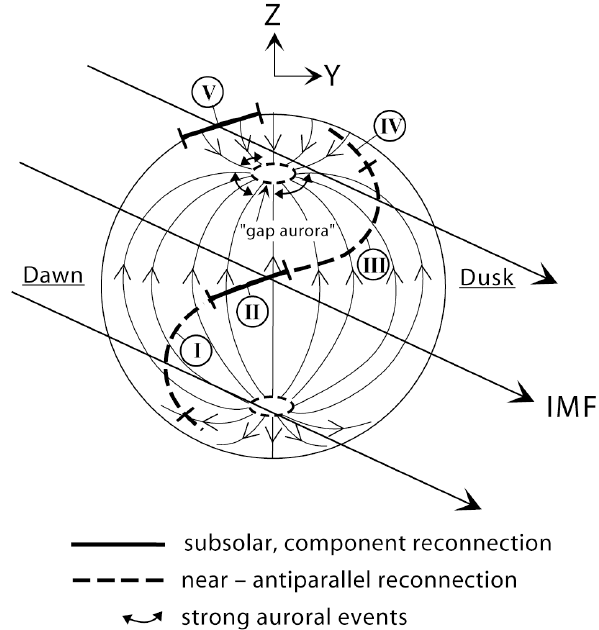
Figure 25 Fig. 25. Reconnection topology for a southeast directed IMF. The Earth’s field (just inside the magnetopause) is indicated. The per- spective is from the Sun towards the Earth. IMF field lines merg- ing with the Earth’s field in different sectors are superimposed. A tilted reconnection line, representing component reconnection at the subsolar, stagnant magnetopause (solid line; segment II) con- nects sectors favourable to antiparallel merging (dashed lines) at higher latitudes in the Southern (prenoon; segment I) and North- ern (postnoon, III) Hemispheres. The stagnation point (magne- tosheath flow) is shifted slightly to the prenoon side of the subsolar point. Regimes in the pre-and postnoon sectors, where strong auro- ral events are observed, as well as the “midday gap aurora” (within 11:00–12:00 MLT), have been marked. The high-latitude magne- topause in the postnoon-dusk and prenoon-dawn sectors are marked IV and V,